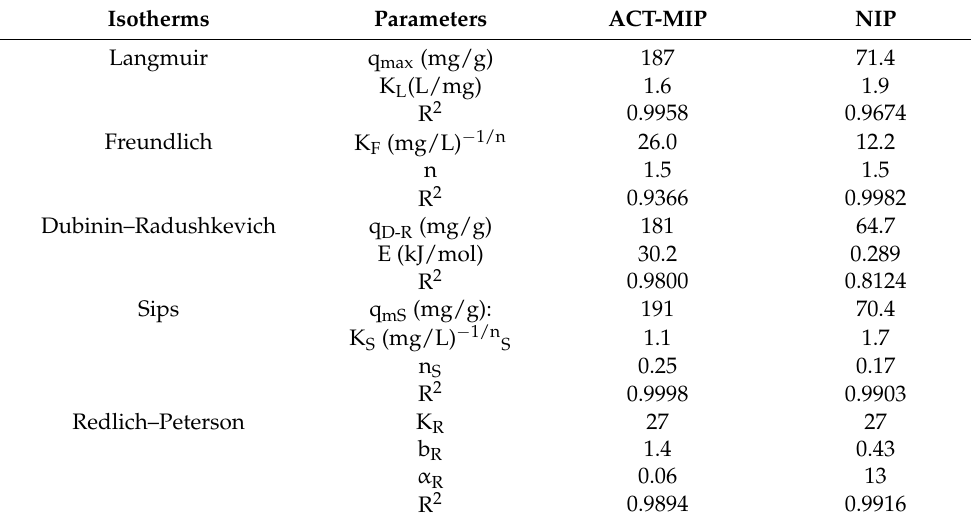
Table 6. Isotherm parameters for the adsorption of ACT by ACT-MIP and NIP.